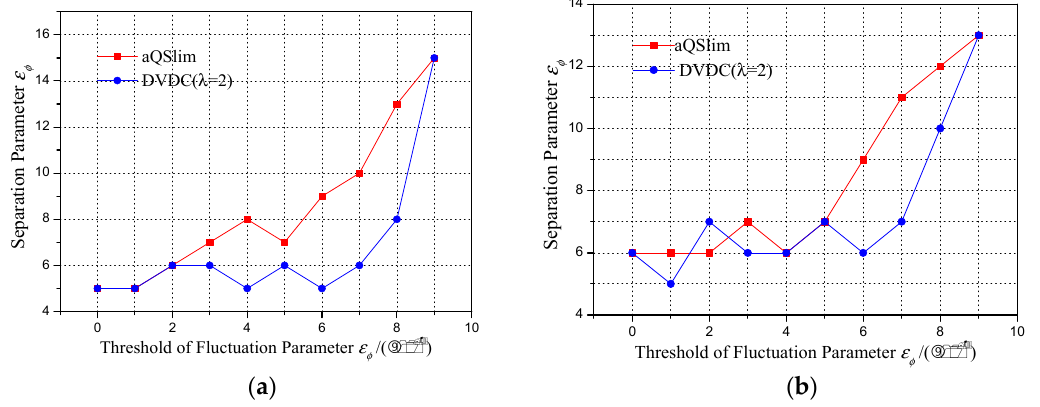
ε decreases as the